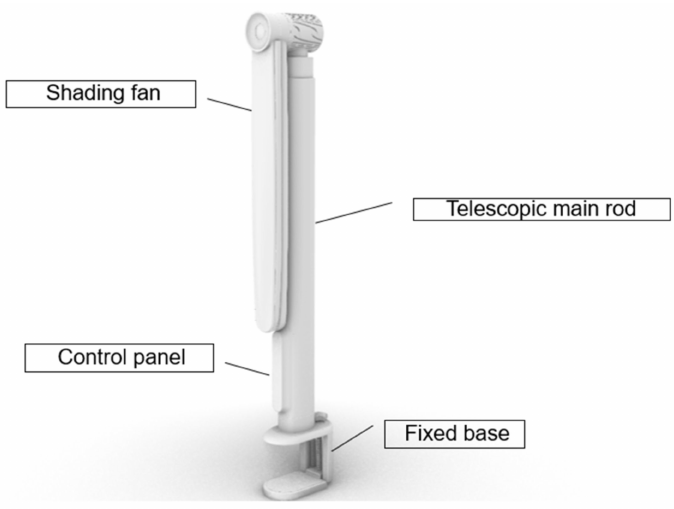
Figure 17. Portable 360 ◦ mobile shading